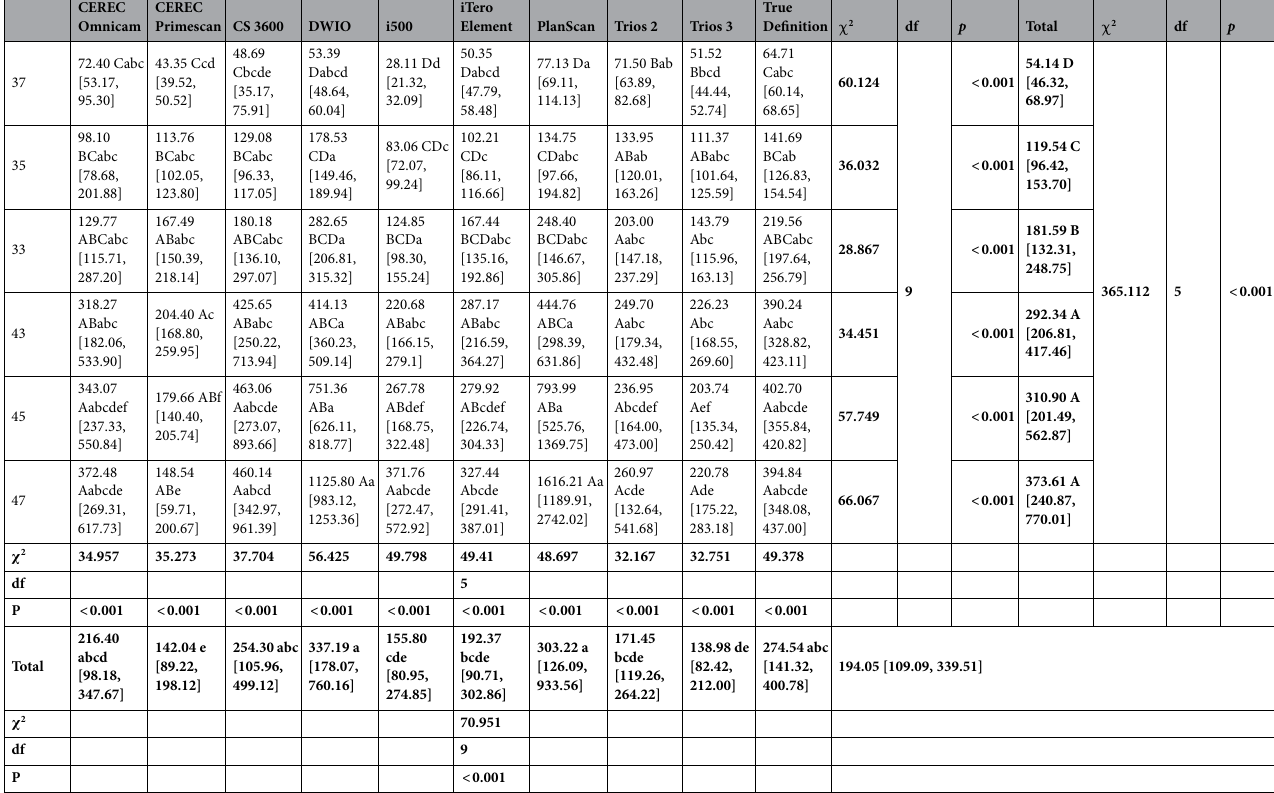
Table 3. Overall 3D deviation (μm) at each cylinder position. χ 2 , chi-square; df, degrees of freedom; p